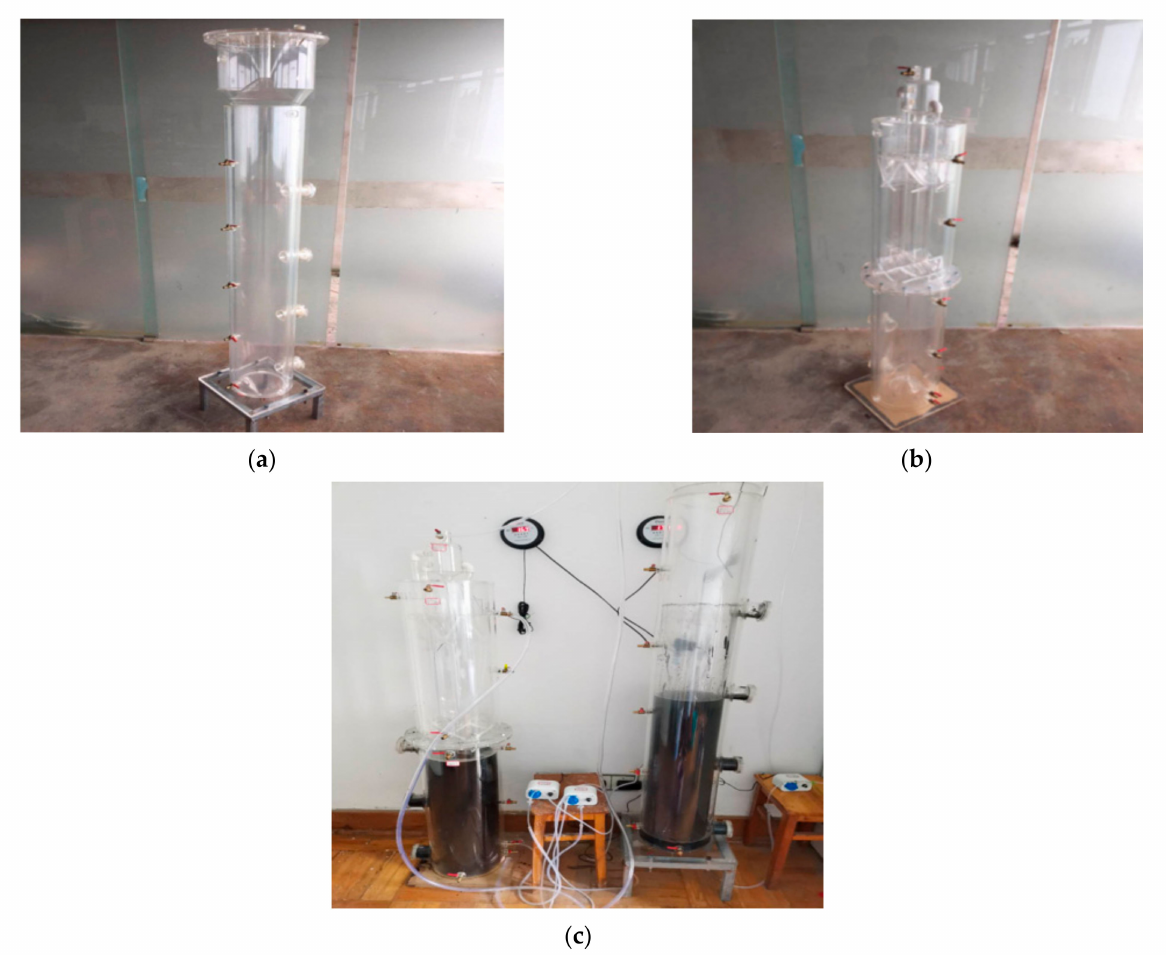
Figure 3. Appearance of the experimental device. ( a ) EGSB reactor. ( b ) IC reactor. ( c ) Combined experimental device.